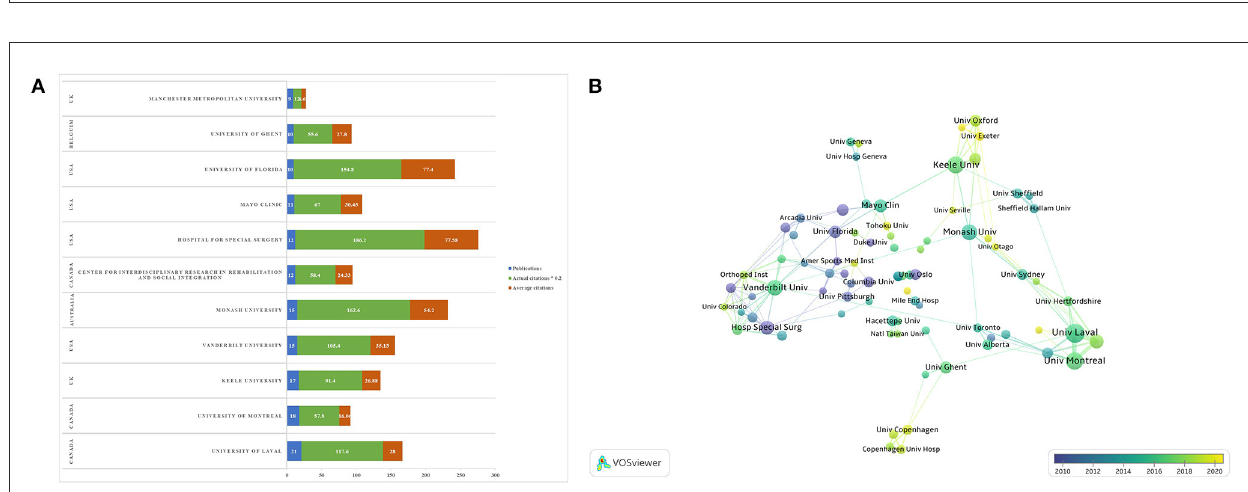
FIGURE4 The information on contributive institutions of the rehabilitation of rotator cuff injury. (A) The number of publications, total citations and citations per year in the top 10 institutions. (B) The co-network visualized map of institutions.